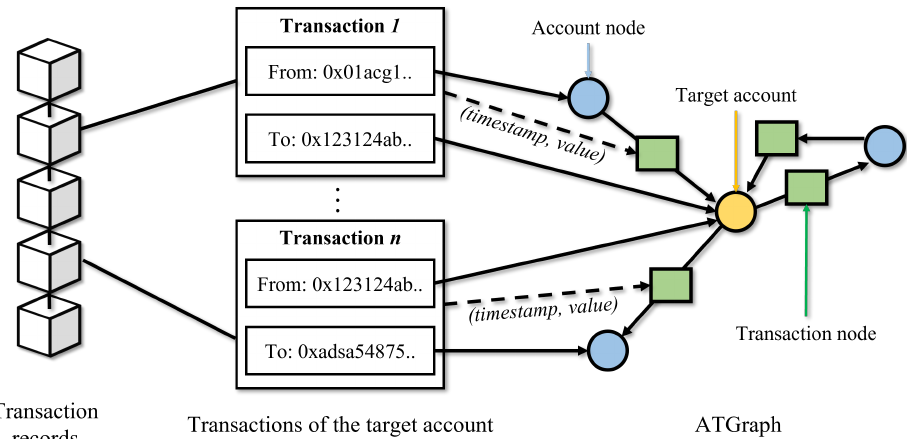
Figure 3. Overview of ATGraph generation based on Ethereum transaction